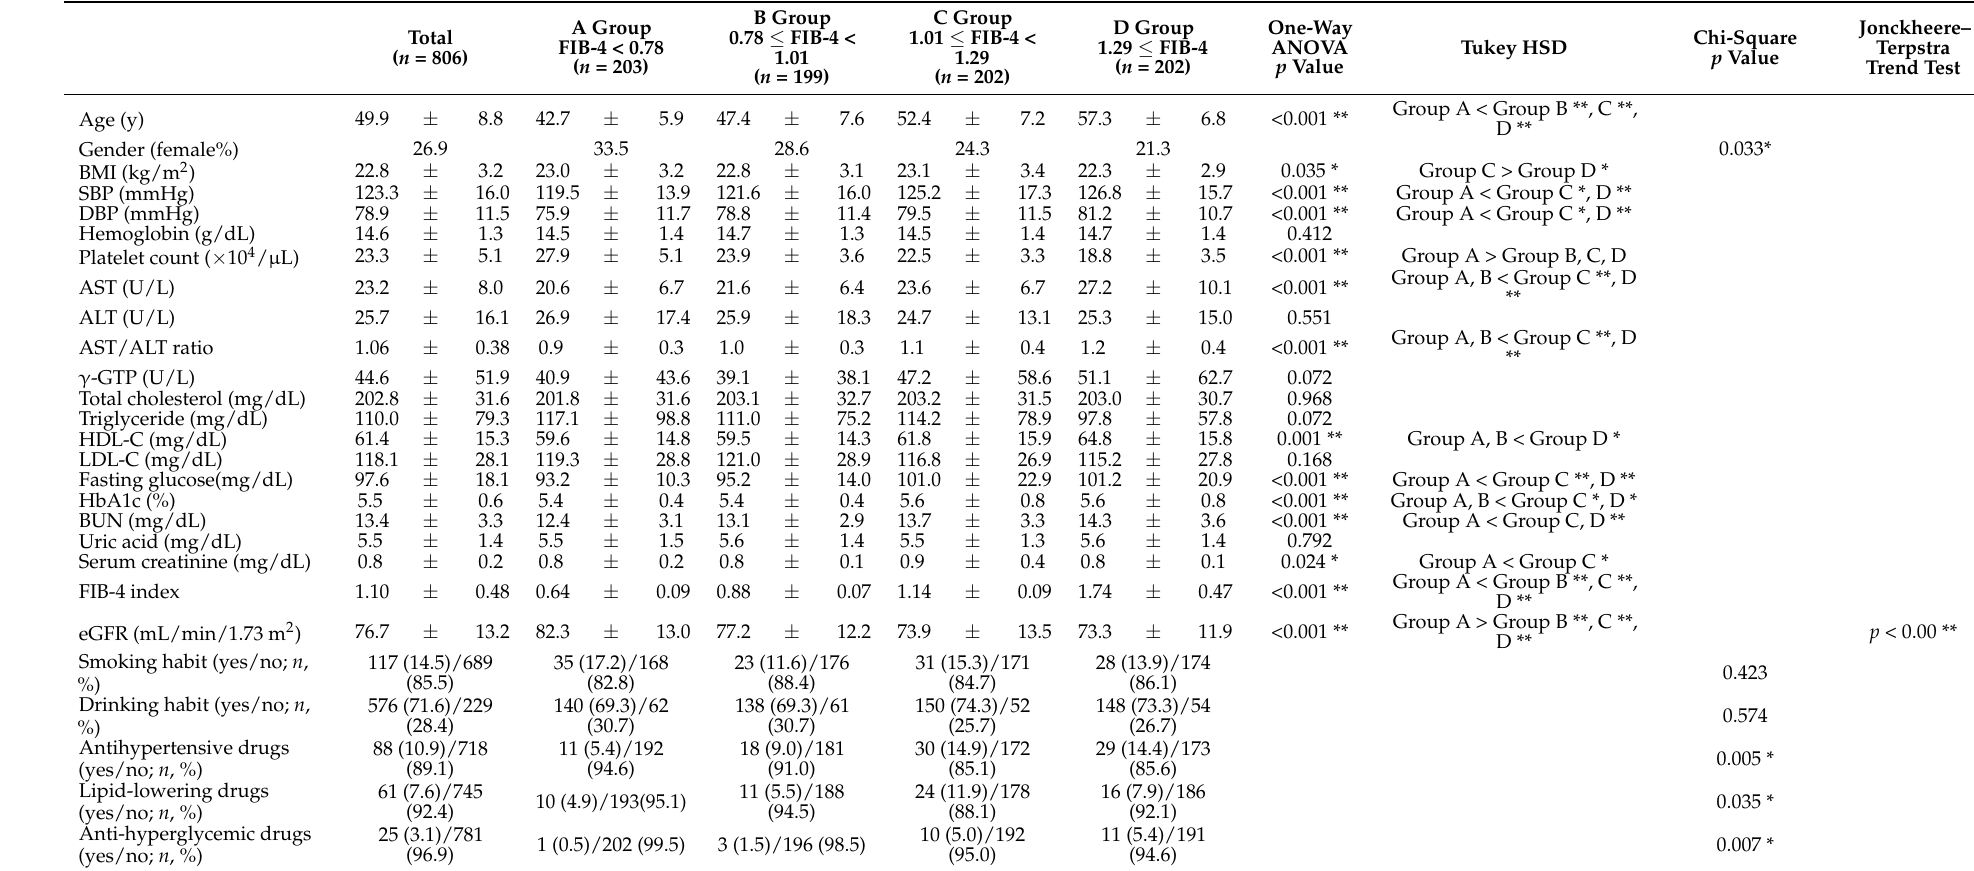
Table 1. The characteristics of subjects in Study